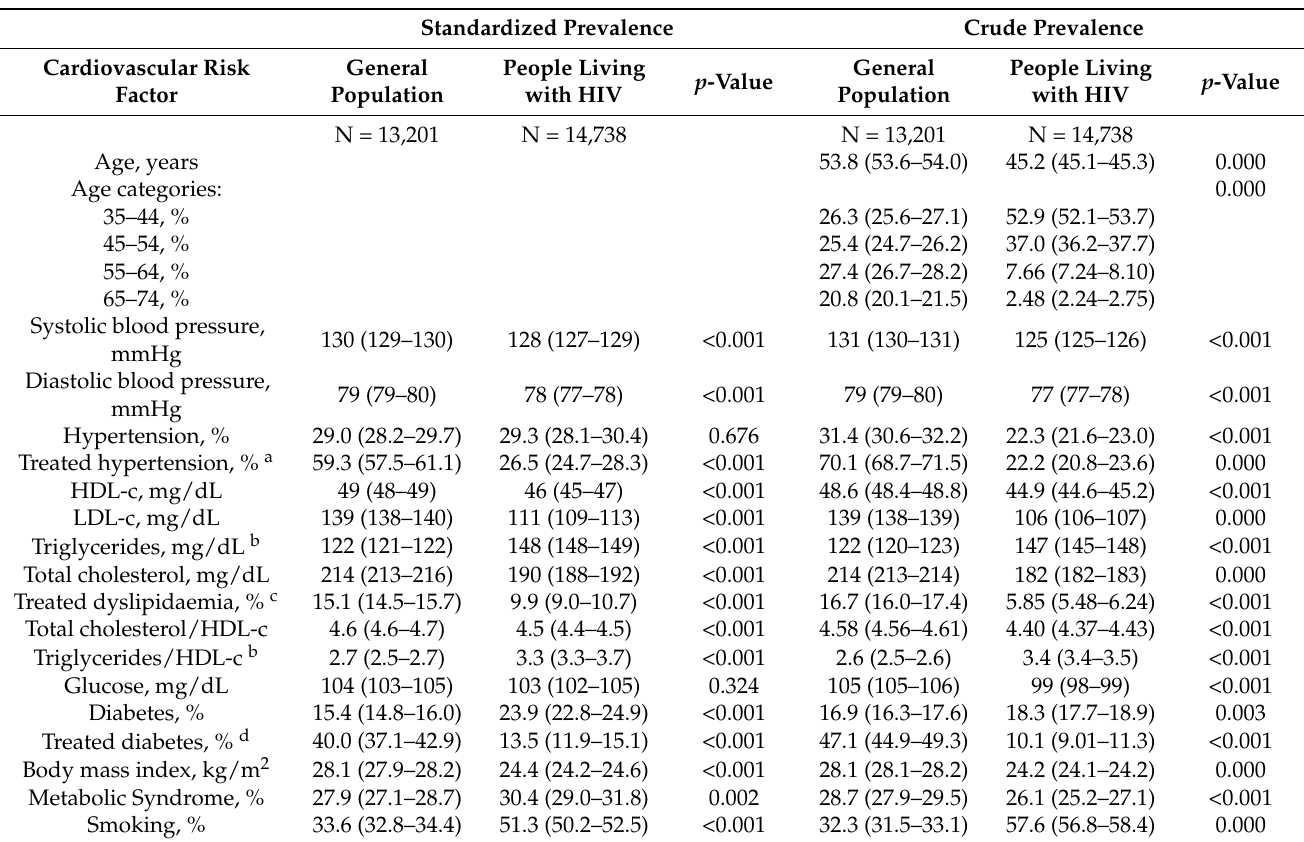
Table 2. Standardized and crude prevalence of cardiovascular risk factors in men from the general population and men living with